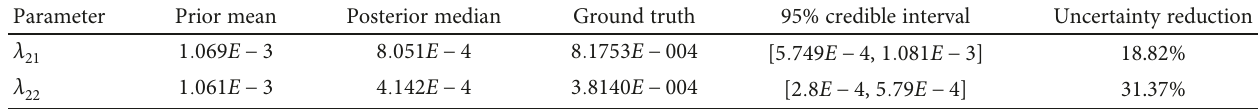
Table 9: Statistical results of the failure rate for the subsystem elements.